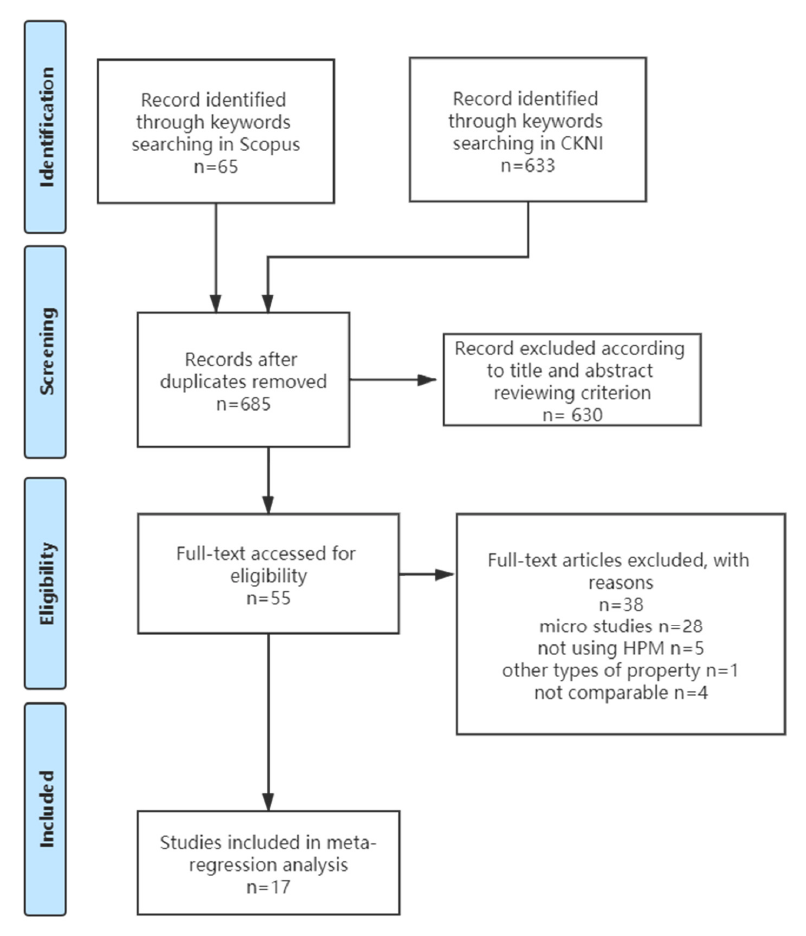
Figure 1. Prisma flow diagram [90].